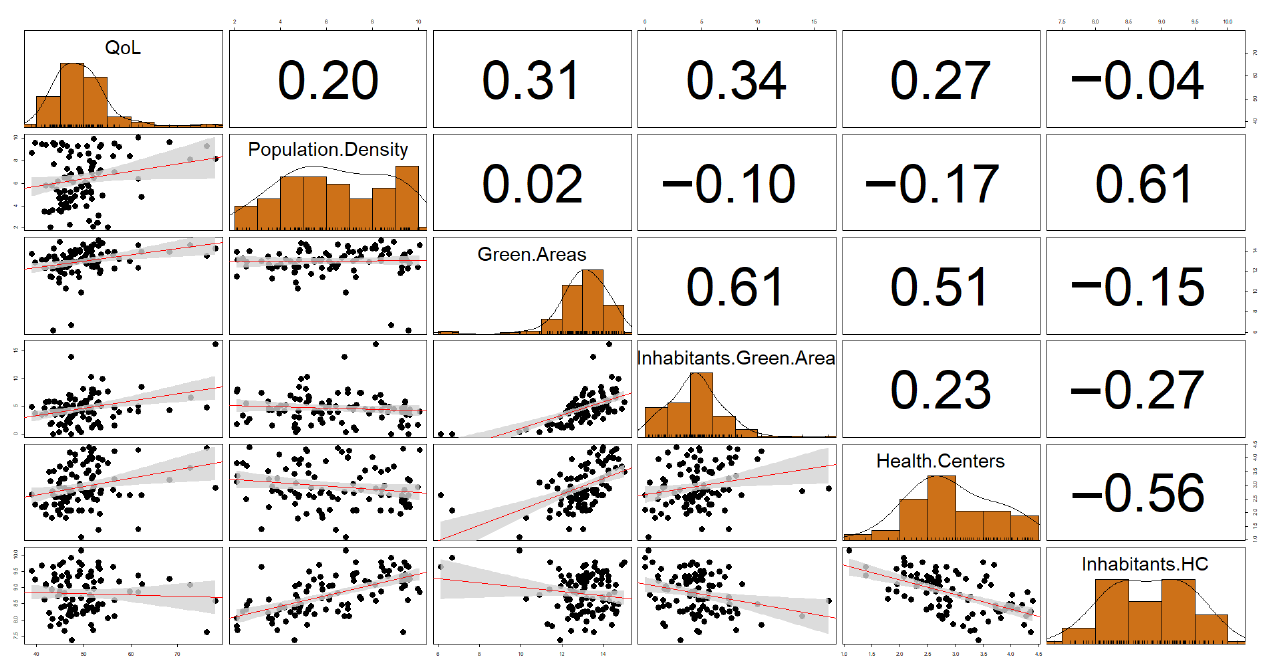
Figure 5. Correlations and scatterplots for quality of life and demographic variables.